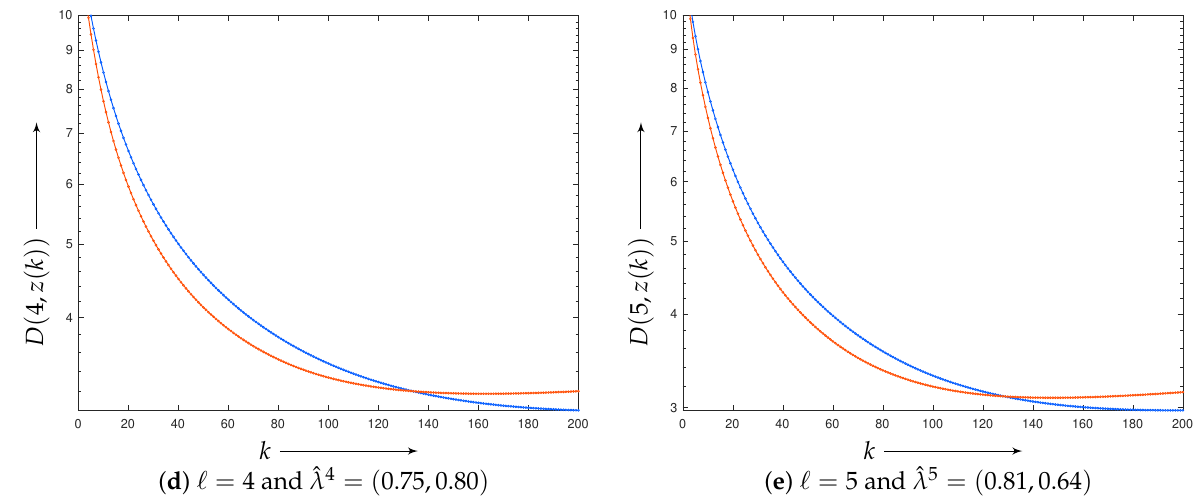
Figure 10. Evaluation function values of z ( k ) with projection y (cid:96) for any k . Blue and red points are for parameters λ = ˆ λ (cid:96) and ( 1,1 ) , respectively.